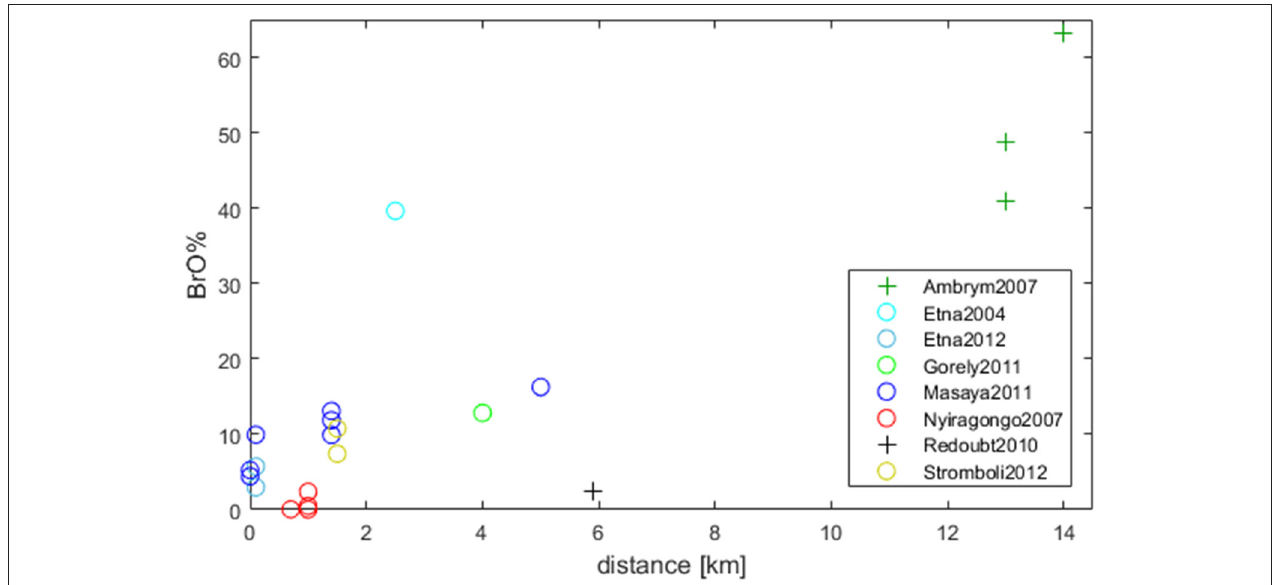
FIGURE 4 | The BrO% fraction is shown dependent on the distance to the emission source. BrO% describes (BrO/SO 2 )/(Br/S). The trend (also observed in Figure 3 ) leads to the assumption that increased BrO/SO 2 is caused by the formation of BrO. Circles (o): simultaneous taken data-sets; Plus ( + ): non-simultaneous data sets but have been compared in other publications (Ambrym: Bani et al., 2009; Allard et al., 2016; Redoubt: Kelly et al., 2013). For further details see Supplementary Table 1 and section BrO as a Fraction of Total Bromine Under Different Plume